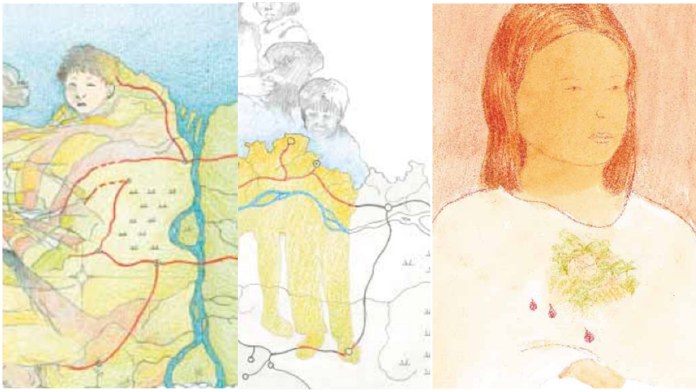
Figure 2. The Ministry of Agriculture’s leaflet on land